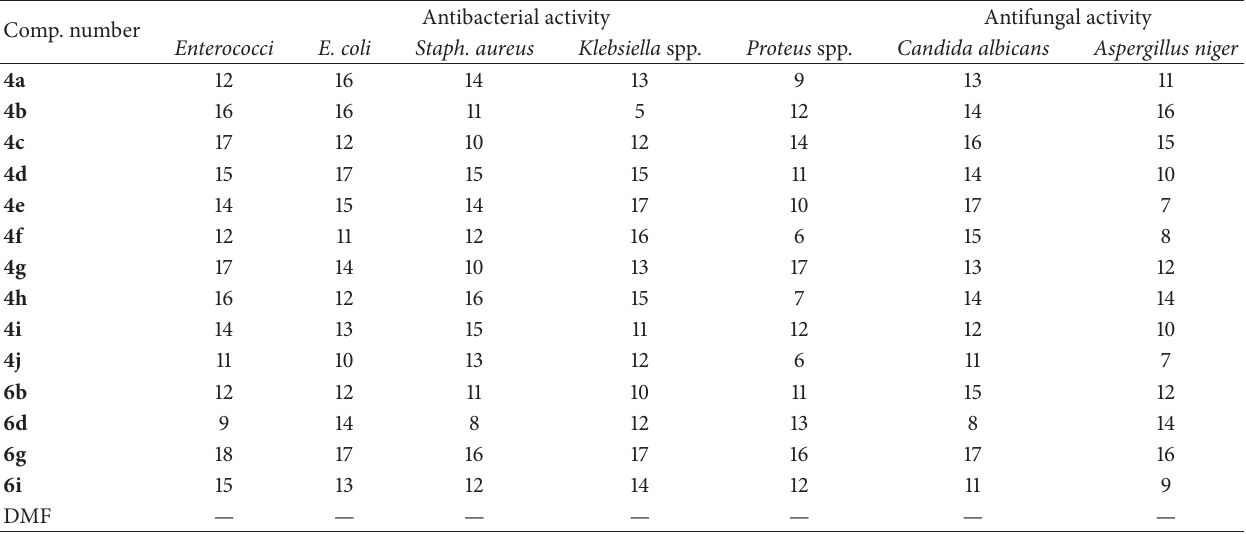
∗ Calculated as average of three